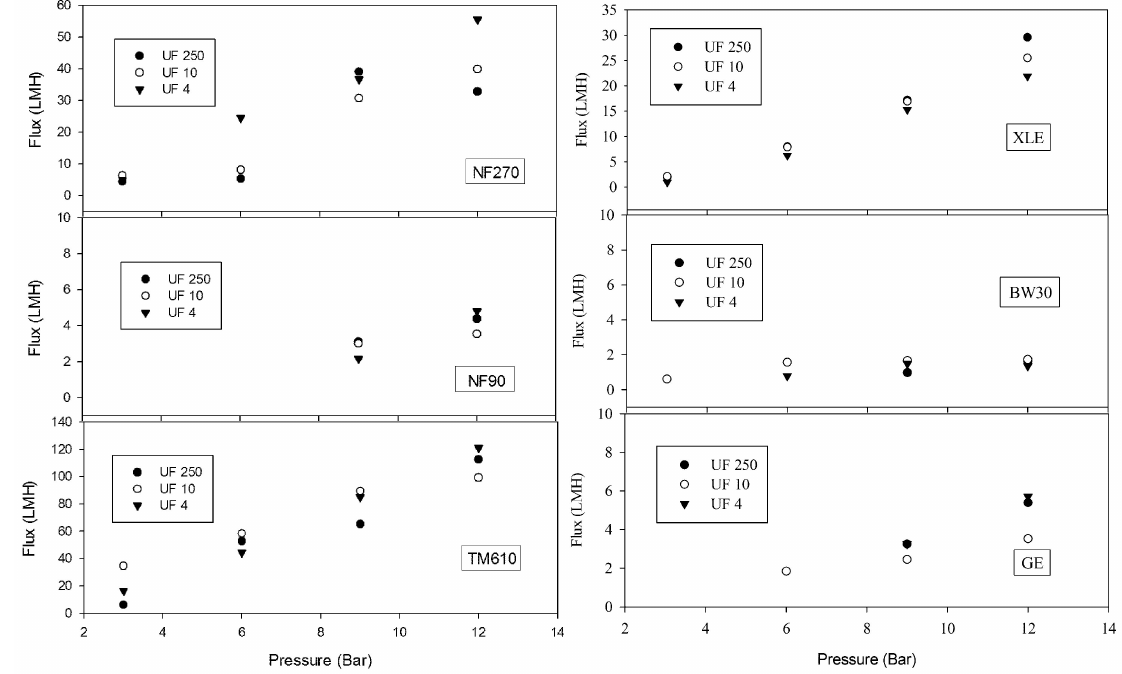
Figure 2. Performances of UF filters in different NF-RO membranes at varying